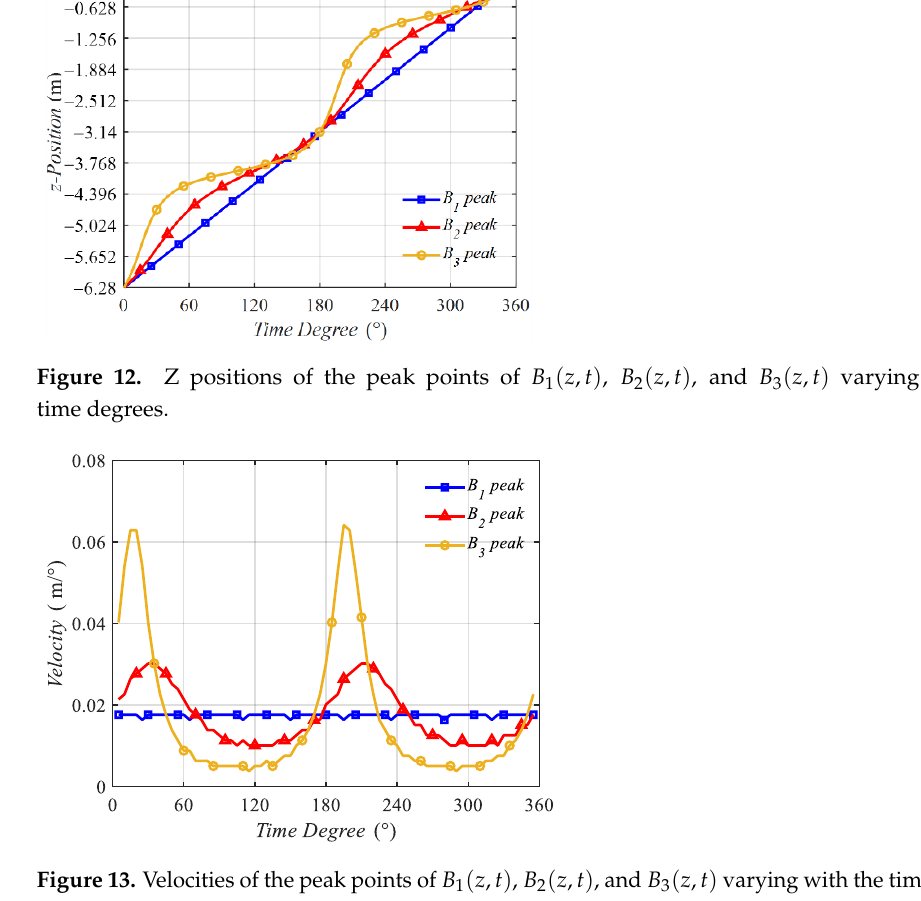
Figure 13. Velocities of the peak points of B 1 ( z , t ) , B 2 ( z , t ) , and B 3 ( z , t ) varying with the time degrees. Table 3. Average velocities in different phase